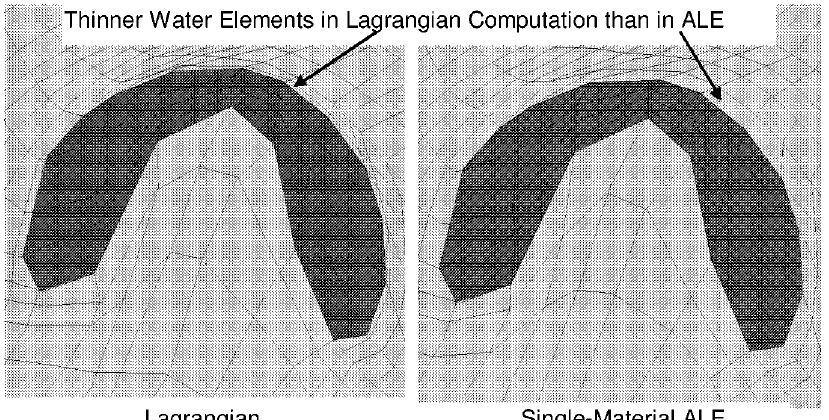
Fig. 9. Comparison of Lagrangian and single-material ALE.